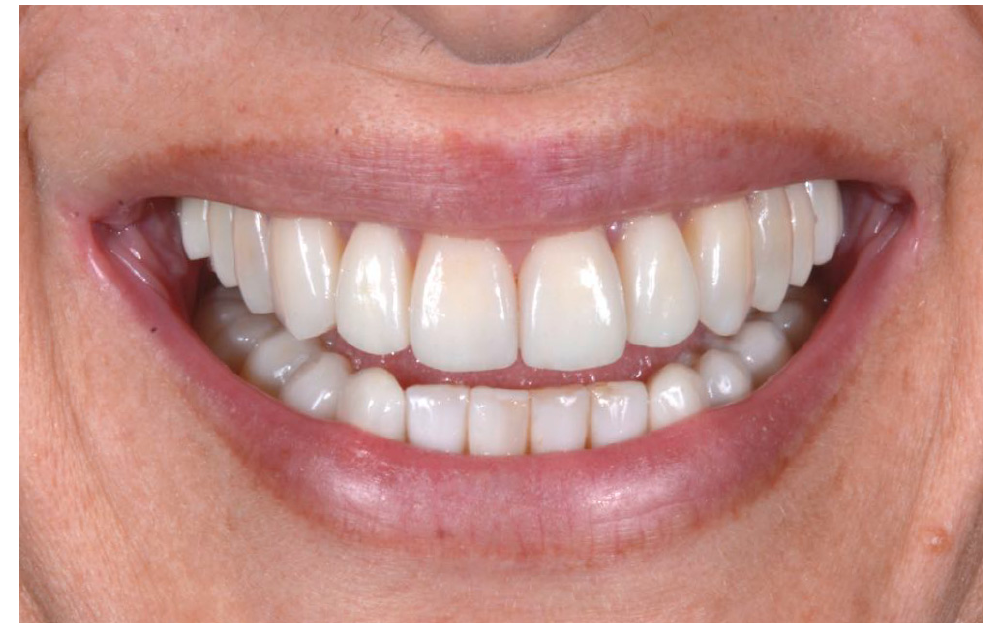
Figure 14. Details of posterior quadrant reconstruction with recovery of the vertical dimension, chewing efficiency, and aesthetics.